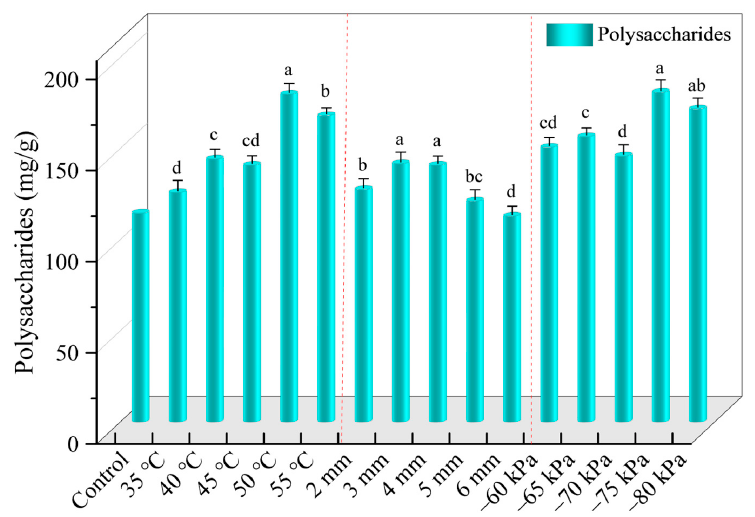
Figure 8. Polysaccharides of Angelica sinensis dried before and after microwave vacuum